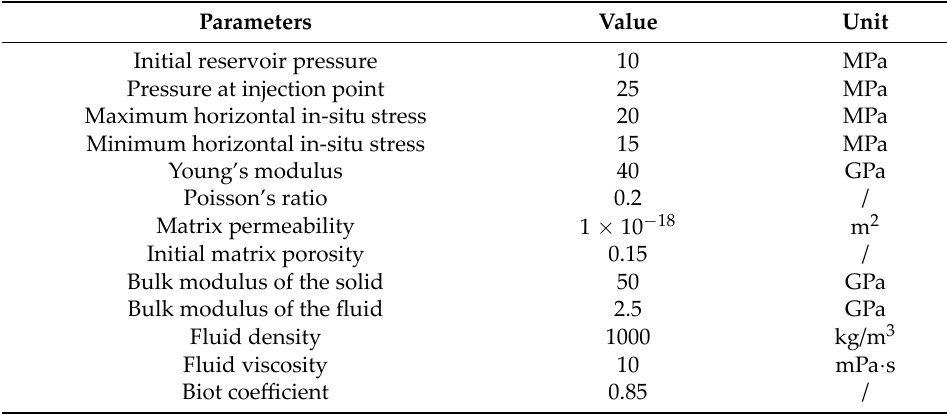
Table 3. Parameters for Validation